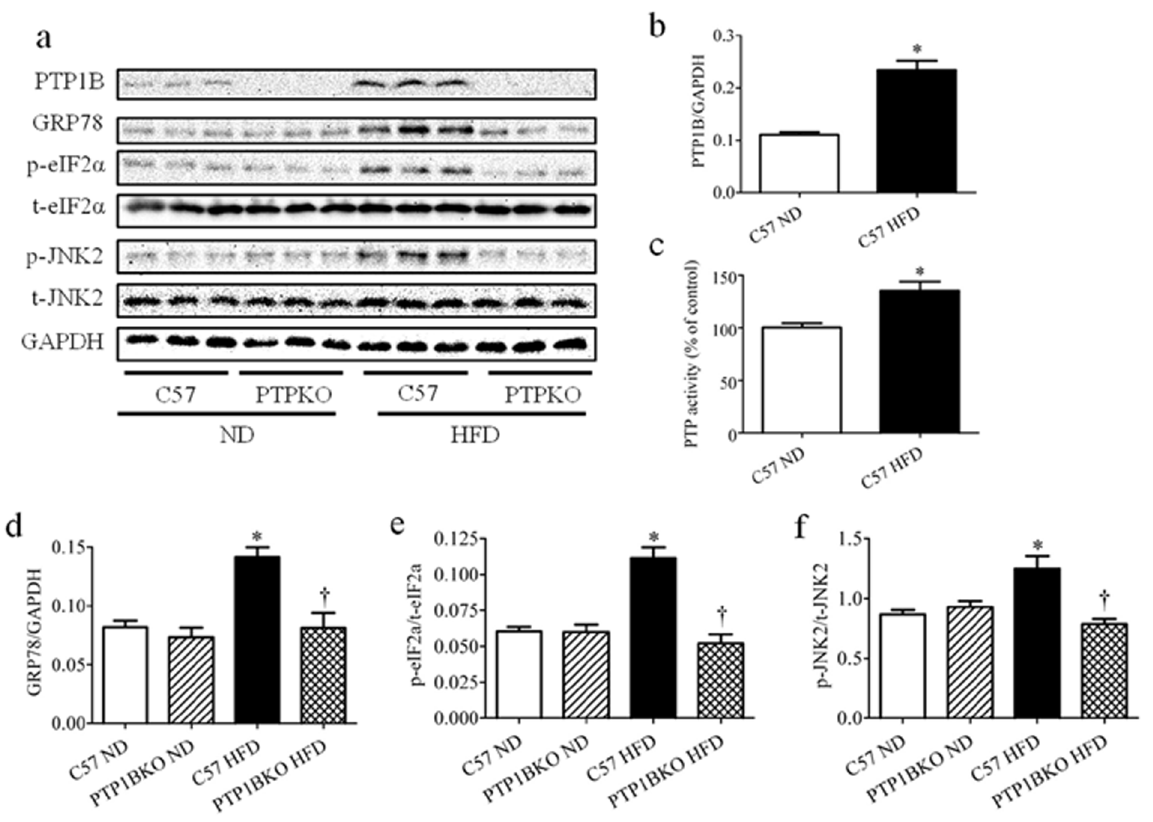
Figure 3. The effect of PTP1B deletion on obesity-induced ER stress in skeletal muscle. Representative Western blots (a), PTP1B activity assay (b) and densitometric analysis (n=6) of PTP1B (c), GRP78 (d), phospho- and total-eIF2 a (p-eIF2 a and t-eIF2 a , respectively) (e), and phospho- and total-JNK2 (p-JNK and t-JNK, respectively) (f) protein levels in gastrocnemius muscles of the C57 or PTP1BKO mice received normal (ND) or high-fat content (HFD) diets for 20 weeks. * p , 0.05 compared with C57 ND mice, { p , 0.05 compared with C57 HFD mice.